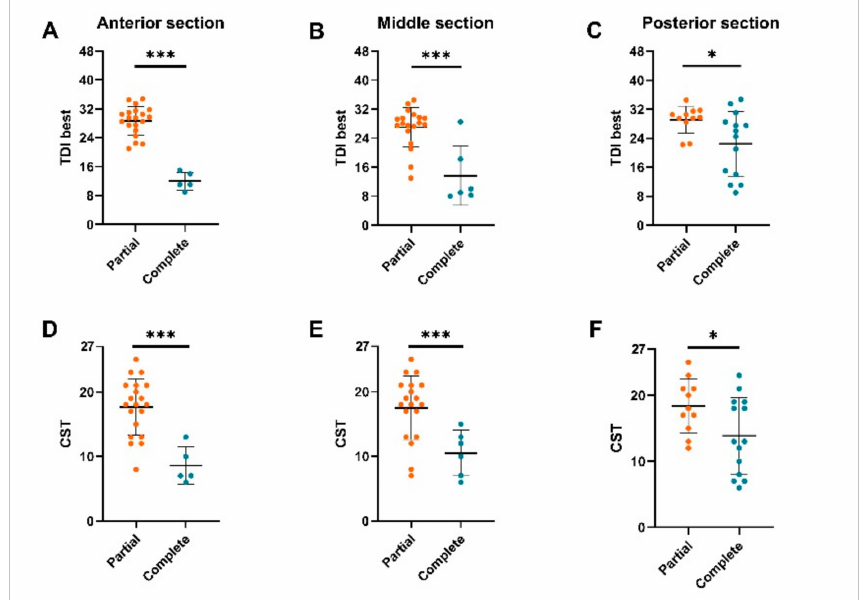
Figure 3. Birhinal orthonasal and retronasal olfactory function in chronic rhinosinusitis (CRS) patients with partial or complete obstruction of the olfactory cleft (OC). OC-opacification were assessed based on an anterior, middle, and posterior two-dimensional coronal plane. TDI best = birhinal orthonasal olfactory function, CST = retronasal olfactory function. OC-opacification assessed in the anterior section ( A , D ), middle section ( B , E ), and posterior section ( C , F ). * p < 0.05, *** p <